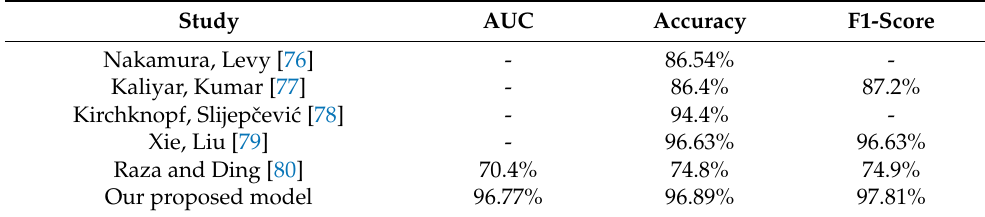
Table 7. The results of the detection models for the benchmarking dataset.